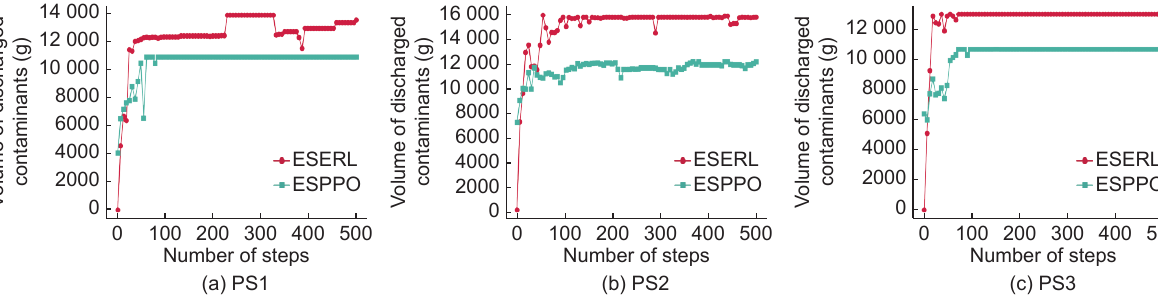
Fig. 6 Volume of discharged contaminants for different single polution events by ESERL and